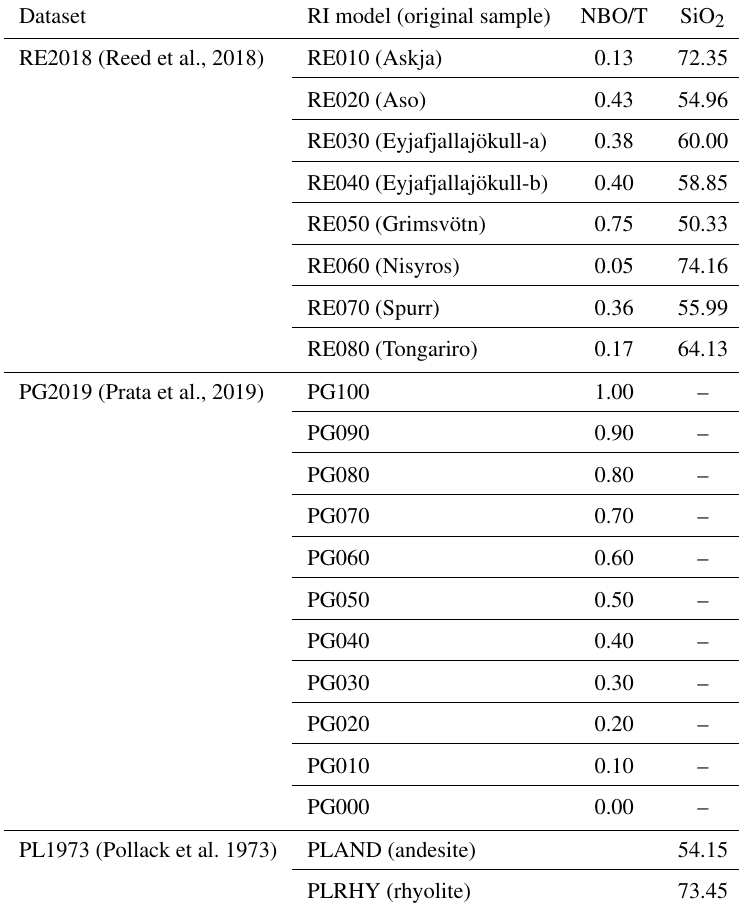
Table 1. Abbreviations for the refractive index (RI) datasets and RI models. The RI models of Reed et al. (2018) (RE2018; RE010–RE080) are listed in alphabetical order and labeled with the name of the corresponding volcanic ash sample. Numbers used for the RI models based on the Prata et al. (2019) (PG2019) dataset (PG000–PG100) represent the ratio of non-bridging oxygens to tetrahedrally coordinated cations (NBO/T). The values of NBO/T and SiO 2 (wt%) for the RI models of RE2018 were calculated from bulk components of the ash samples and derived by PG2019. PLAND and PLRHY are “andesite” and “obsidian from Little Glass Mountain, California” by Pollack et al. (1973). The wavenumber dependence of each RI model is plotted in Figs.